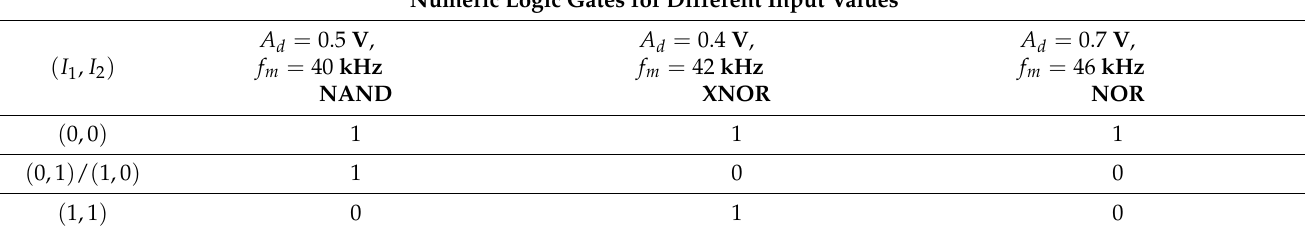
Table 3. With parameters f m = 40 kHz and A d = 0.5 V, a NAND gate can be obtained by the numerical model. On the other hand, for f m = 42 kHz and A d = 0.4 V, an XNOR gate is generated. For f m = 46 kHz and A d = 0.7 V, a NOR gate is